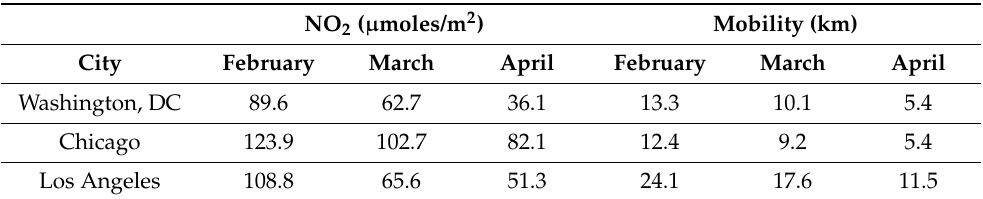
Table 1. Monthly average distribution of NO 2 ( µ moles/m 2 ) concentration and mobility (km). NO 2 (µmoles/m 2 ) Mobility (km)